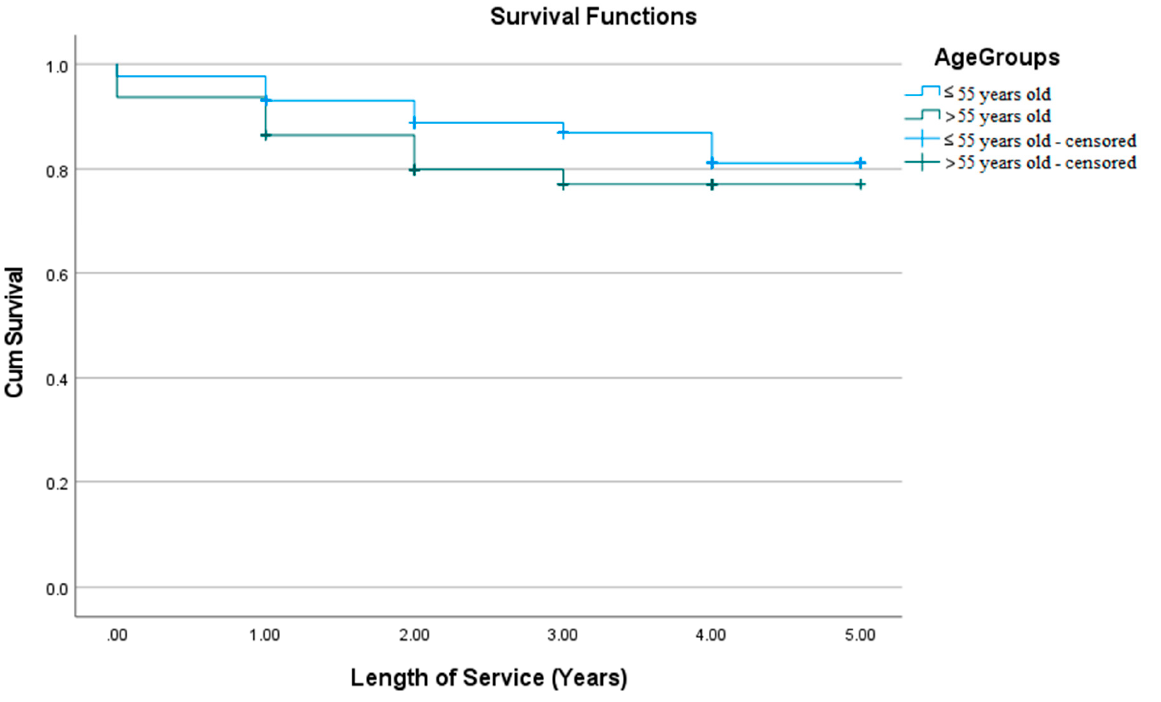
Figure 4. Kaplan-Meier survival curve of composite restorations stratified by age group, Palacky University Hospital, 2014–2018 ( n = 469). CumSurvival = cumulative survival. The composite-based cements had significantly ( χ 2 = 10.310; Sig. = 0.001) higher sur- vival (4.51 ± 0.07) than the resin-based cements (3.90 ± 0.21) (Figure 5).